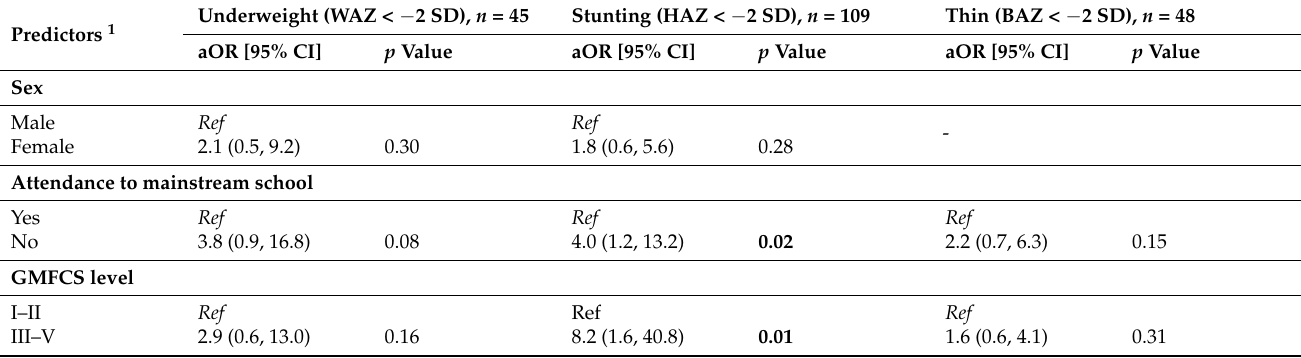
Table 4. Predictors of underweight, stunting and thinness among children with CP in Gorkha, Nepal (Adjusted analysis). Predictors